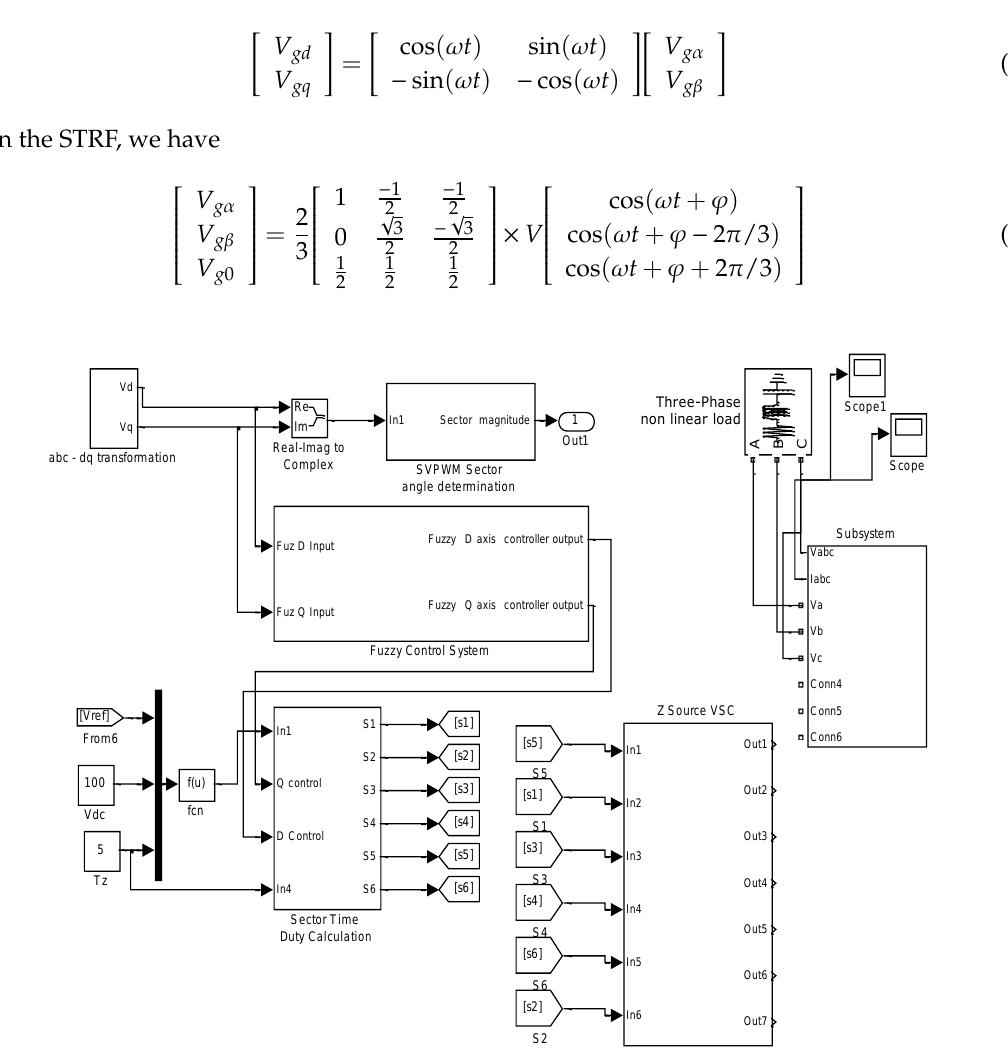
Figure 4. A block diagram of a Z-source VSC with a fuzzy-logic-based SVPWM controller.